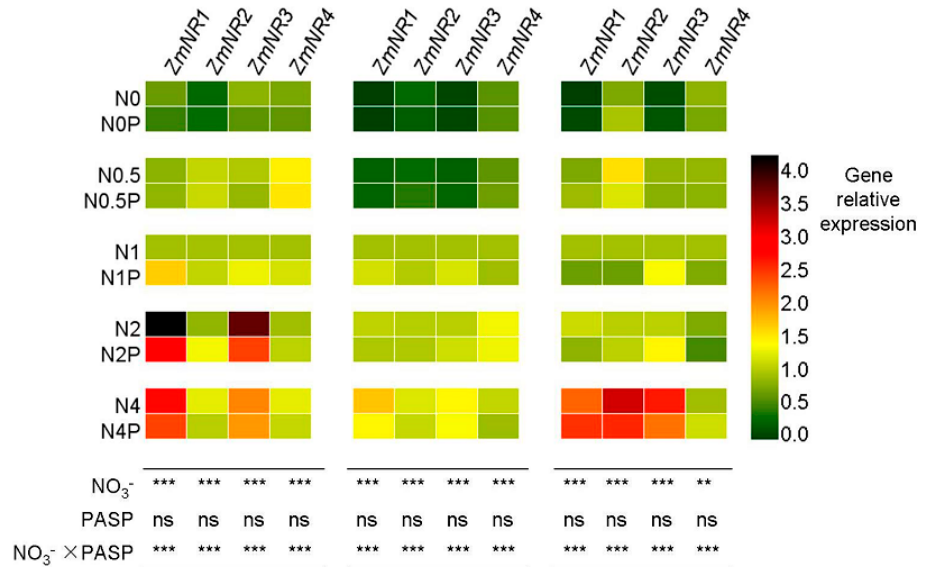
Figure 5. Relative expression of ZmNR1 , ZmNR2 , ZmNR3 , and ZmNR4 in the leaves on the 1st, 3rd, and 7th day after PASP treatment. Data were presented as the mean of 15 plants in each treatment. ns, *, **, and ***, Statistically significant differences according to multiple analyses at p > 0.05, p < 0.05, p < 0.01, and p < 0.001. N0, N0.5, N1, N2, and N4 indicate the seedlings treated with 0, 0.5, 1.0, 2.0, and 4.0 mmol L − 1 of NO 3 − without PASP treatment, respectively. N0P, N0.5P, N1P, N2P, and N4P indicate the seedlings treated with 0, 0.5, 1.0, 2.0, and 4.0 mmol L − 1 of NO 3 − plus PASP addition, respectively.